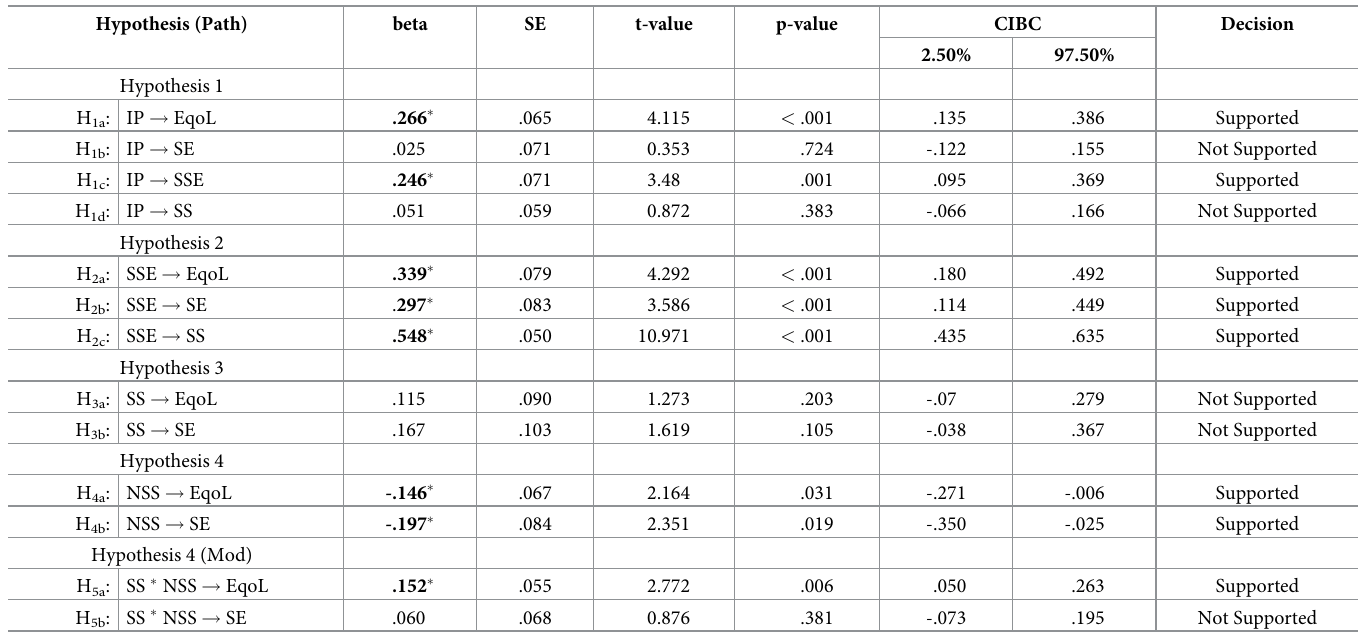
Table 5. Hypotheses, results, and conclusions of direct and moderating effects. Hypothesis